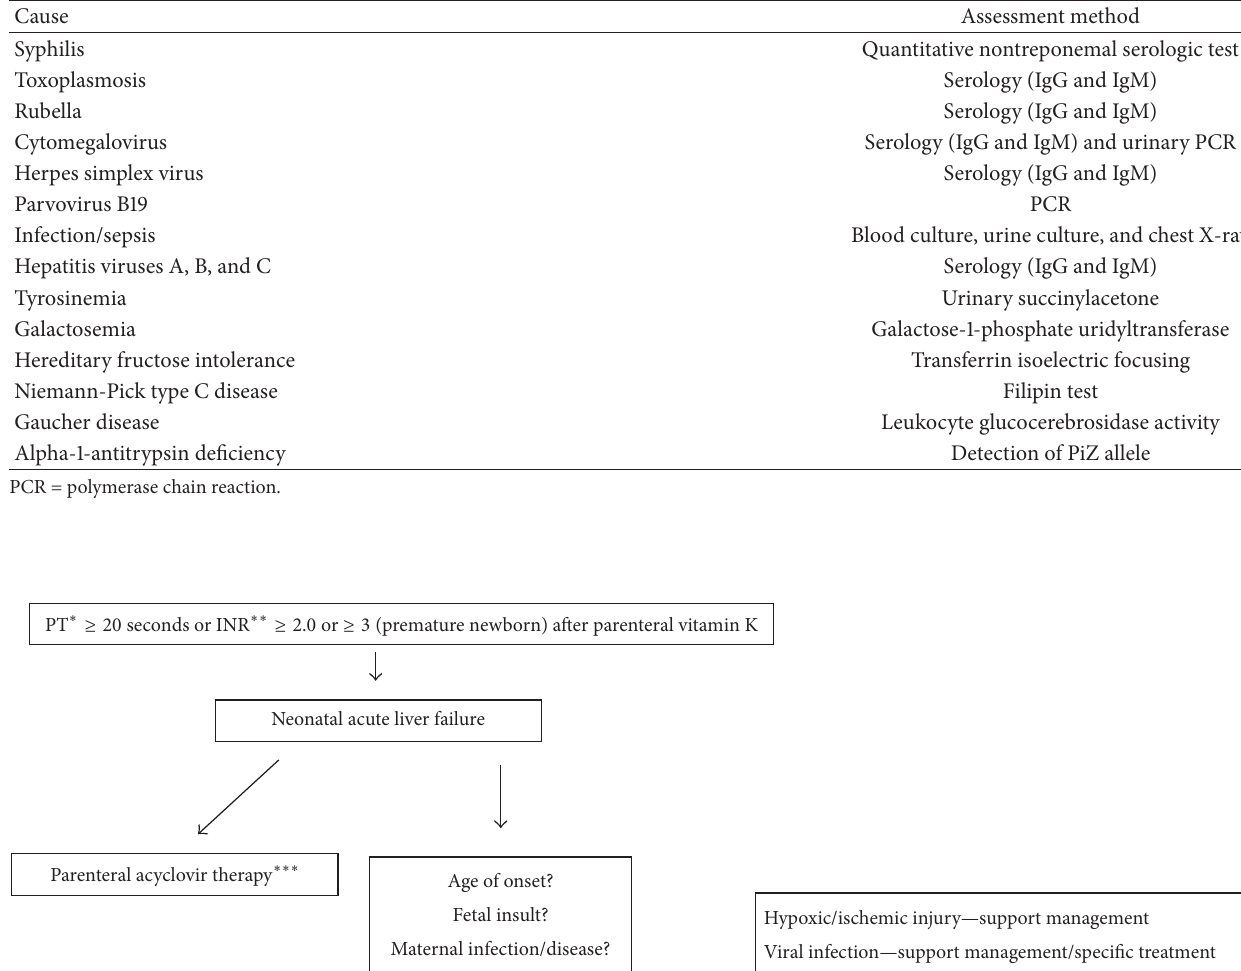
Table 2: Causes of neonatal liver failure excluded and assessment methods.